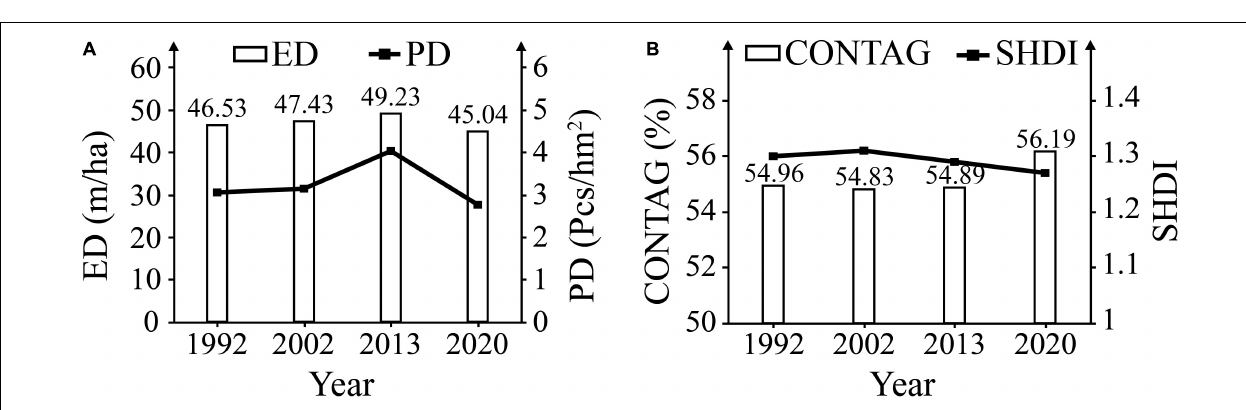
FIGURE 5 | Changes in landscape pattern metrics at the landscape level during the four periods at the Changshagongma Wetland Nature Reserve. (A) edge density (ED) and patch density (PD), (B) contagion index (CONTAG) and Shannon diversity index